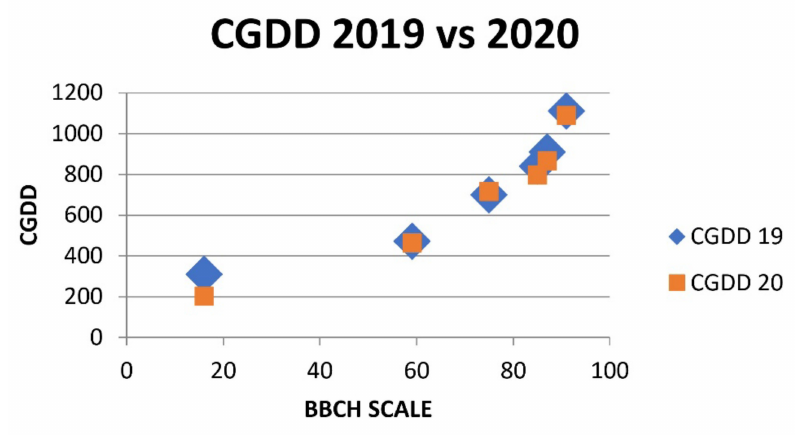
Figure 3. The CGDD necessary to reach the same BBCH stage in the 2019 and 2020 seasons.